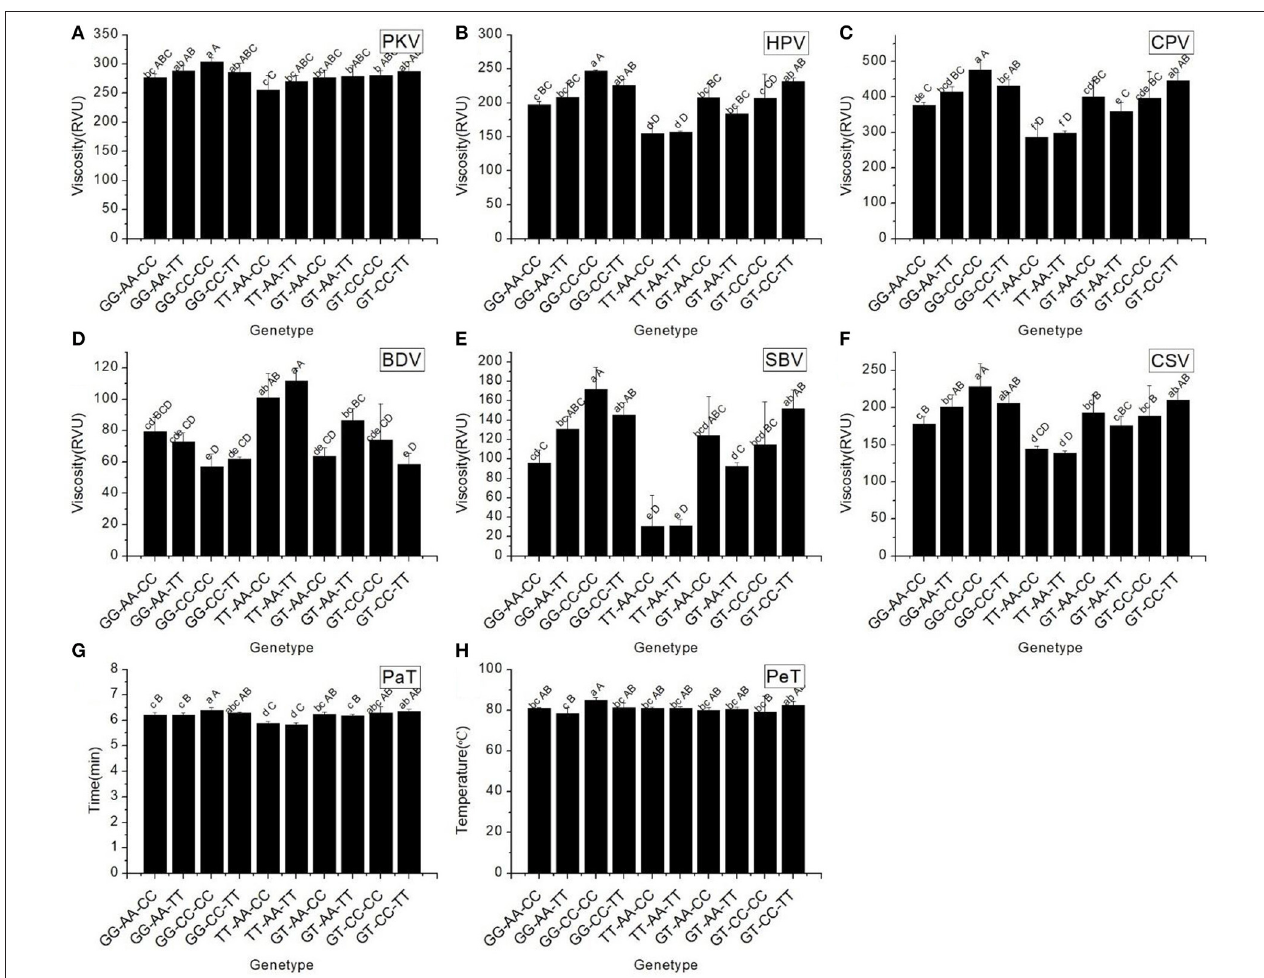
FIGURE 4 | RVA profile characteristics for different haplotypes of In1G/T, Ex6A/C and Ex10C/T polymorphisms of Wx . (A) Peak viscosity (PKV). (B) Hot paste viscosity (HPV). (C) C ool paste viscosity (CPV). (D) Breakdown valve (BDV). (E) Setback valve (SBV). (F) Consistency valve (CSV). (G) Pasting temperature (PaT). (H) Pasting time (PeT). GG-AA-CC, GG-AA-TT, GG-CC-CC, GG-CC-TT, TT-AA-CC, TT-AA-TT, GT-AA-TT, GT-AA-TT, GT-CC-CC and GT-CC-TT represent different haplotypes of In1G/T, Ex6A/C and Ex10C/T polymorphisms of Wx . Lowercase and capital letters above column denote significant at 0.05 and 0.01 levels, respectively.